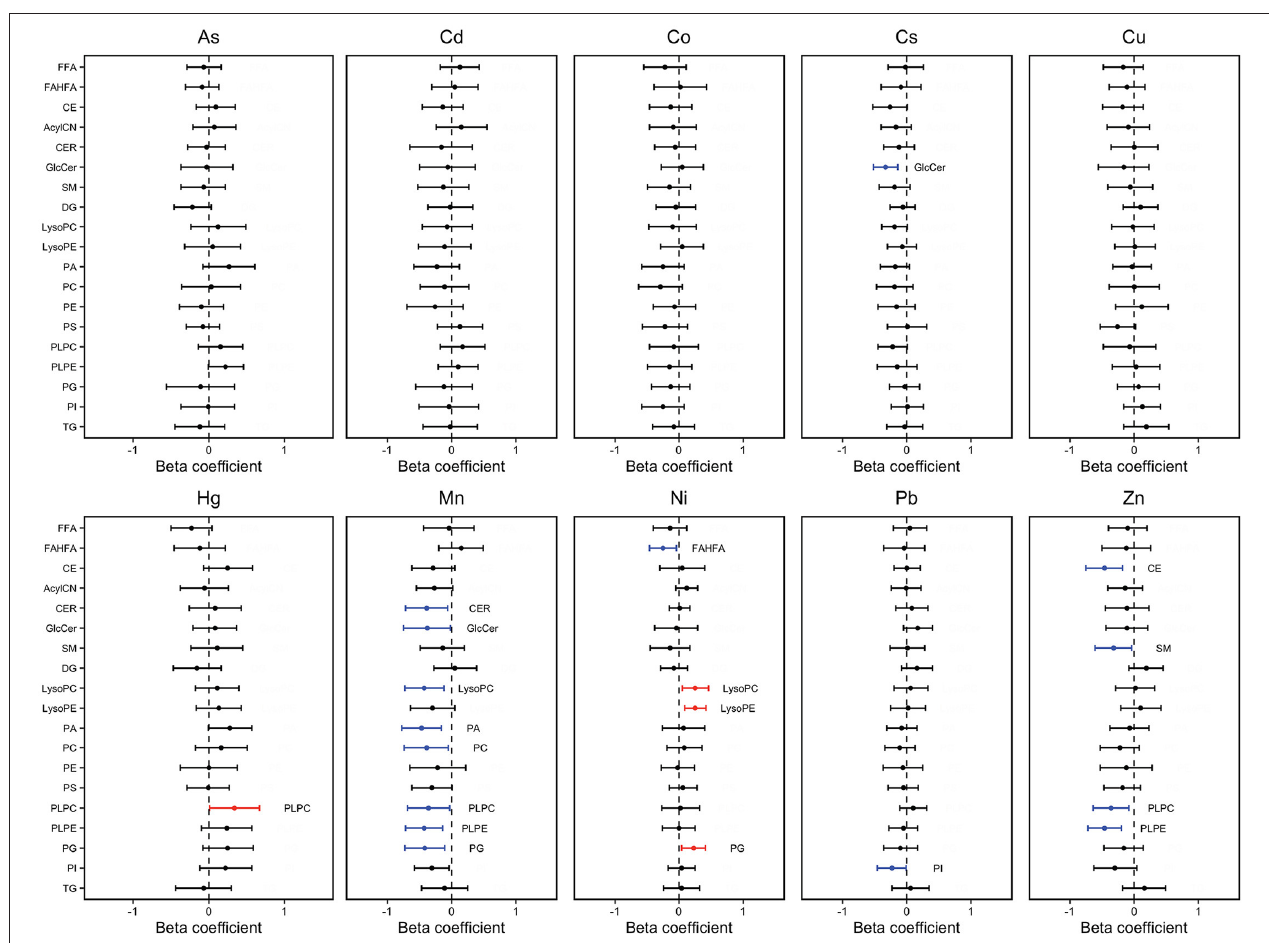
FIGURE 4 | Percent change in lipid class sum z-score associated with maternal metal/metalloid blood concentrations. Effect estimates presented as percent change (%) for IQR increase in exposure biomarker concentration ab . Models were adjusted for maternal age, maternal education, fetal sex, pre-pregnancy BMI, weight gain during